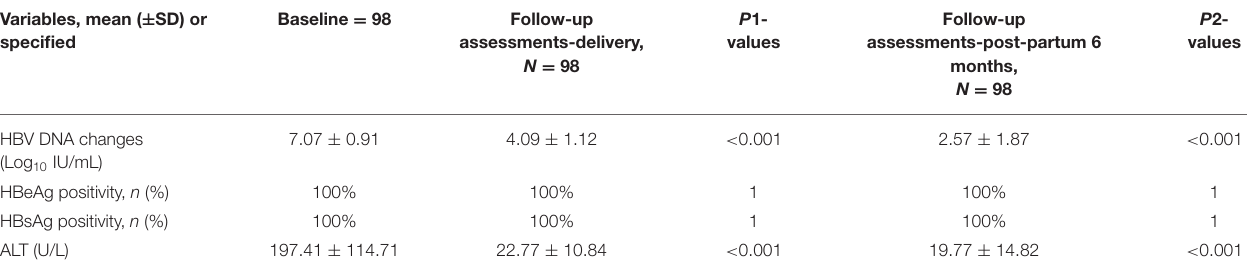
TABLE 5 | Maternal treatment effects with tenofovir alafenamide fumarate. Variables, mean ( ± SD) or specified